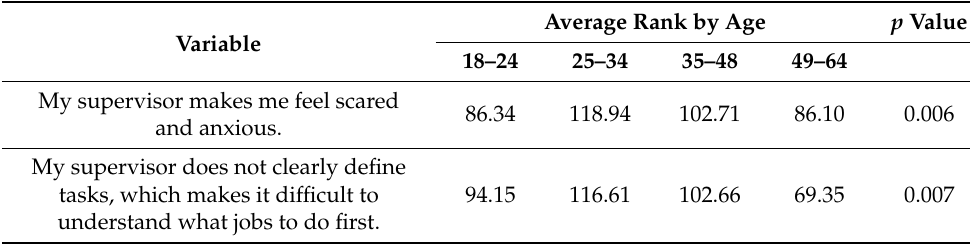
Table 7. Causes of stress when working from home by age.